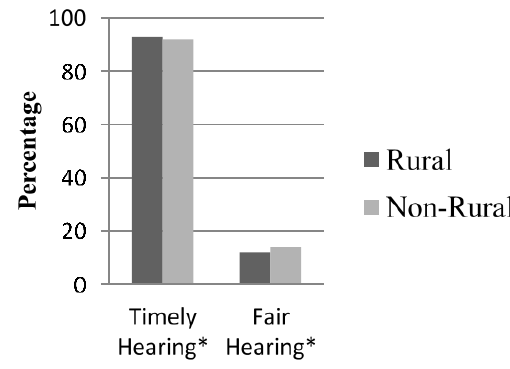
Figure 2. TennCare Appellate Hearings by Jurisdiction.